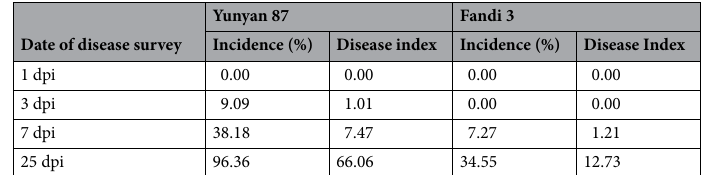
Date of disease